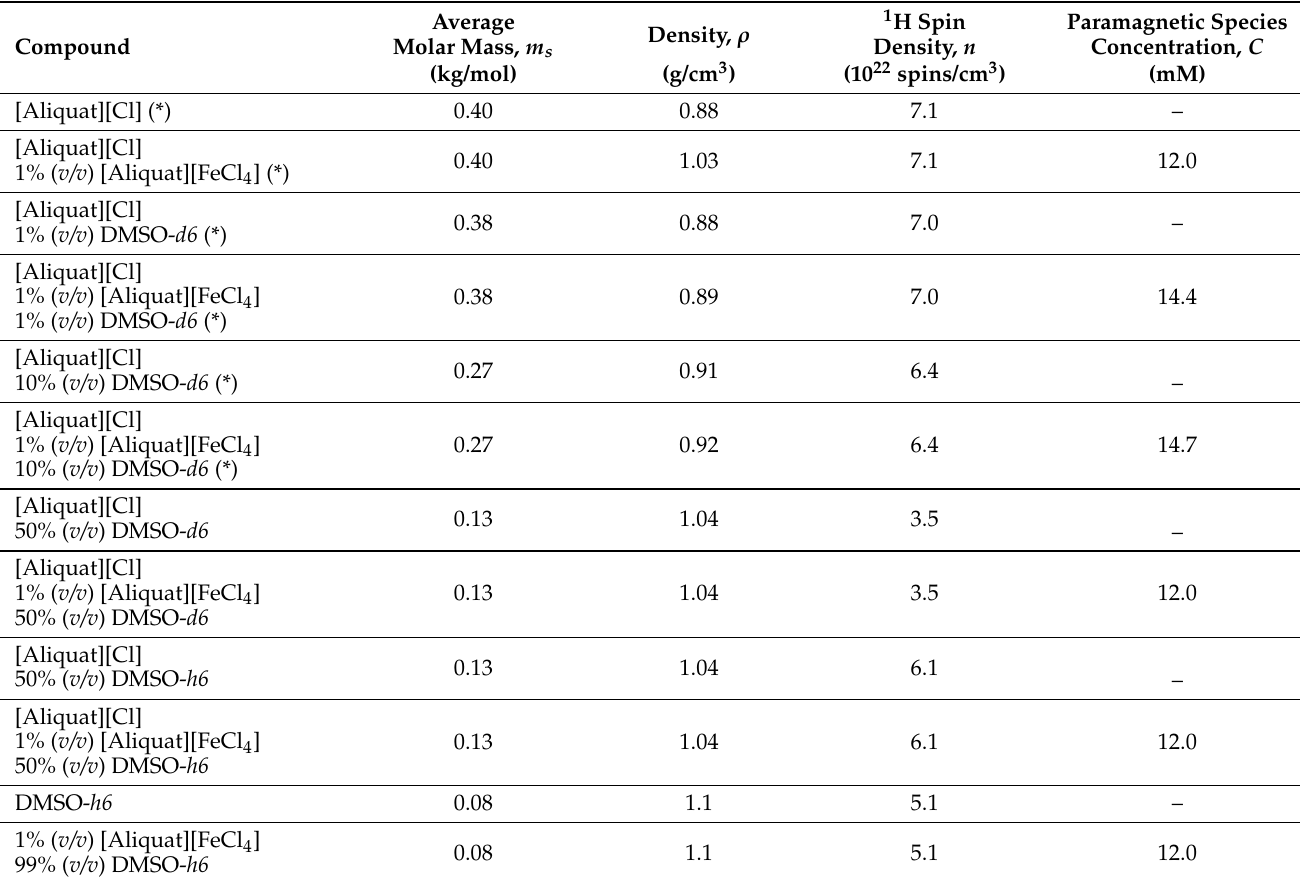
Table 1. Average molar mass, density, spin density and molar concentration of magnetic particles of the studied systems. (*)-samples reported in Beira et al.